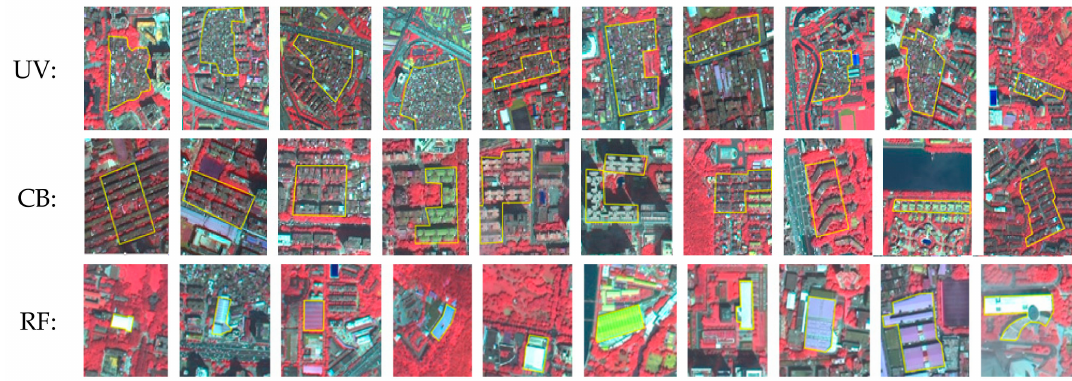
Figure 4. Sample selection: UV, CB and RF (From top to bottom).